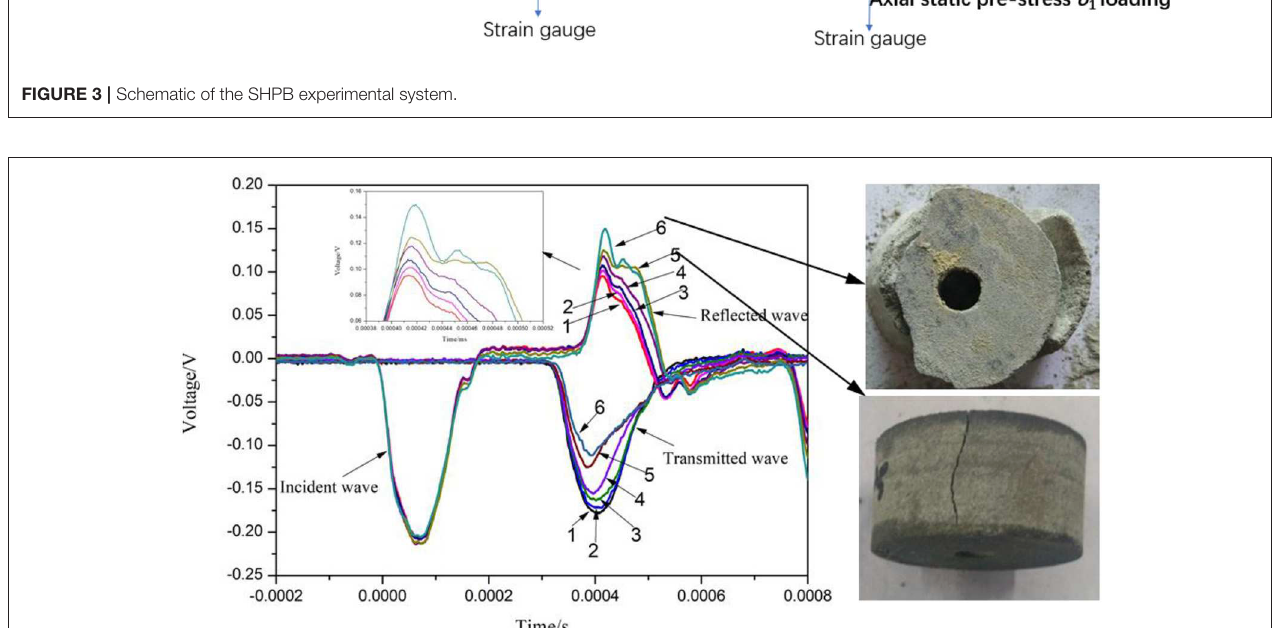
FIGURE 4 | Waveform of specimen under cyclic